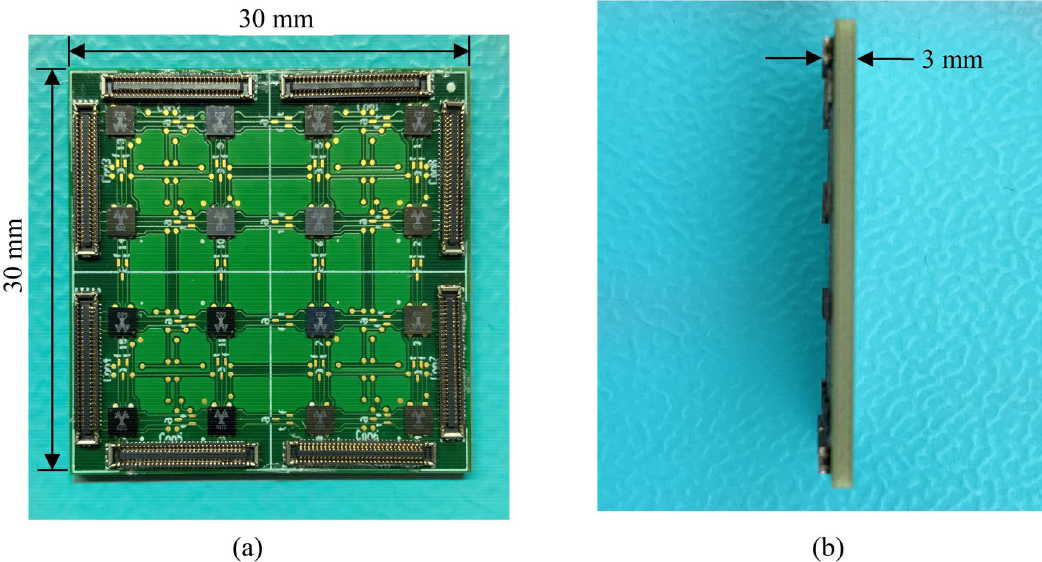
Figure 6. Photograph of a 4 × 4 chip grid. ( a ) Front view, and ( b ) side view. Note the very small thickness of the populated test-board.